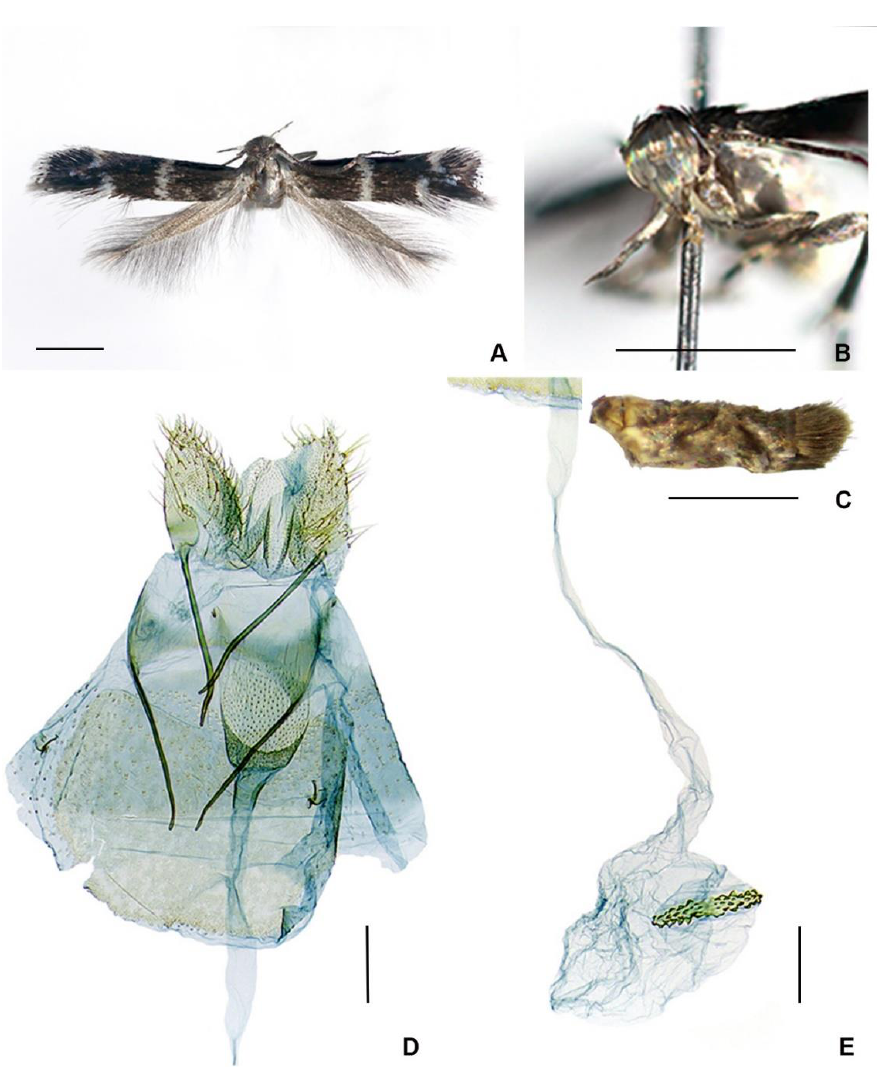
Figure 3. Elachista stonisi sp. nov., female, holotype: ( A ) adult; ( B ) head, fronto-lateral view; ( C ) ab- domen, lateral view; ( D ) caudal part of genitalia; and ( E ) ductus and corpus bursae. Scale bars: ( A – C ) = 1 mm; ( D , E ) = 0.1 mm.